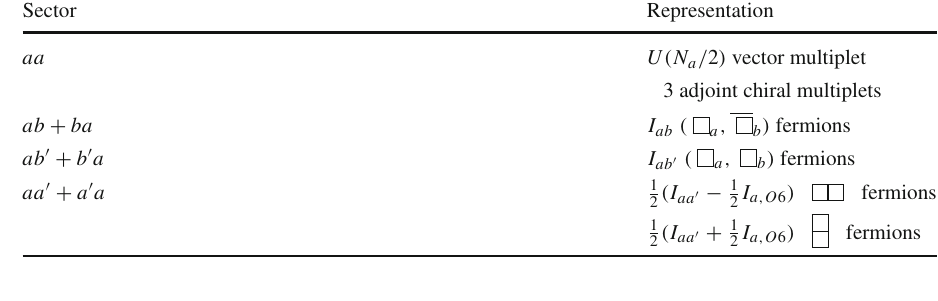
Table 2 The wrapping numbers for four O6-planes